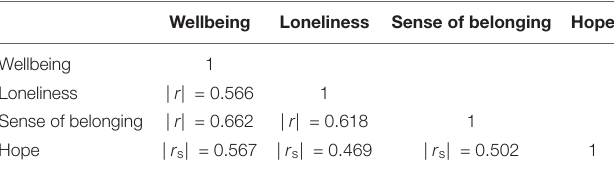
TABLE 2 | Correlations between baseline wellbeing, loneliness, sense of belonging and hope.